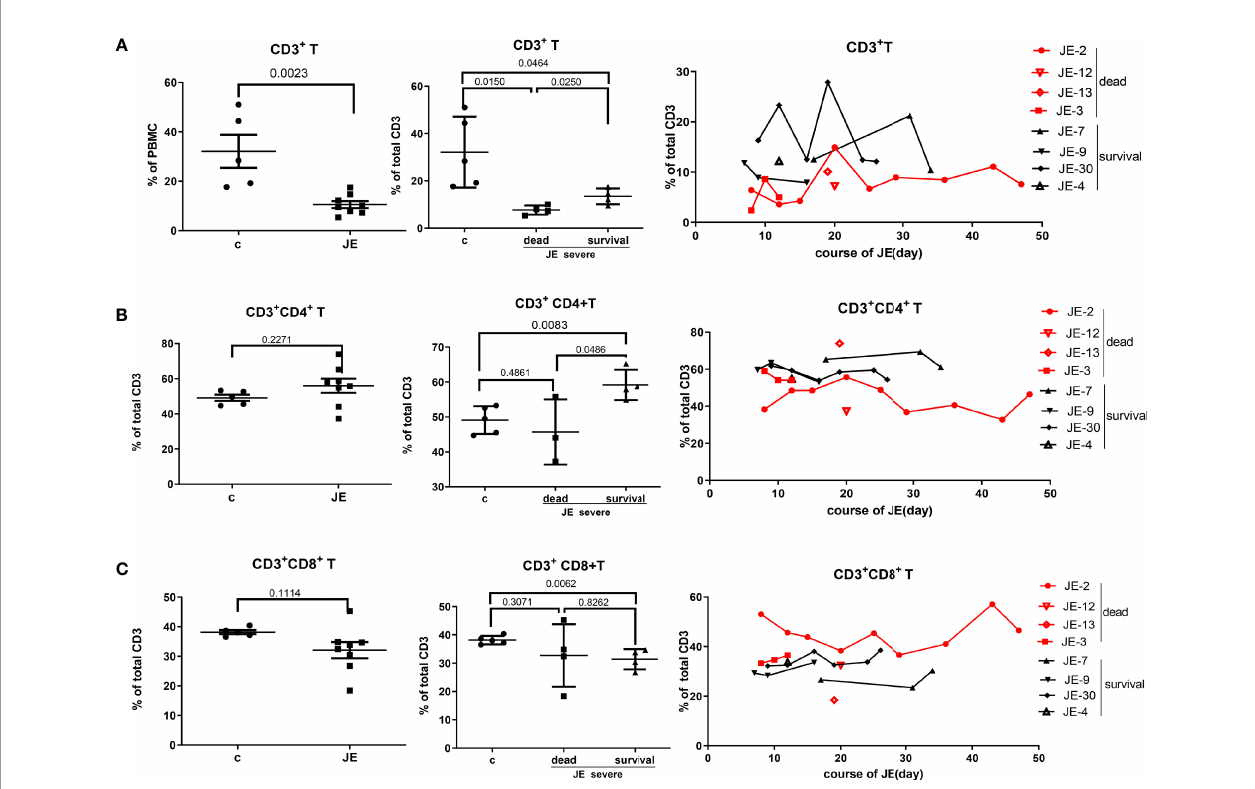
FIGURE 6 | The divergence of T cells and main subsets in JE patients with different progression. The PBMCs from severe JE patients with different outcomes were collected at several time points. The percentages of T cells, CD4 + T cells, and CD8 + T cells were detected by fl ow cytometry and analyzed using FlowJo Software v7.6. The data in the severe patients were the mean percentage from several time points of each patient. (A) The percentage and comparison of CD3 + T cells in the PBMCs from the healthy controls and severe JE patients and the dynamic development of CD3 + T cells in the severe JE patients with dead or survival outcome. (B) The percentage and comparison of CD3 + CD4 + T cells in the PBMCs from the healthy controls and severe JE patients and the dynamic development of CD3 + CD4 + T cells in the severe JE patients with dead or survival outcome. (C) The percentage and comparison of CD3 + CD8 + T cells in the PBMCs from the healthy controls and severe JE patients and the dynamic development of CD3 + CD8 + T cells in the severe JE patients with dead or survival